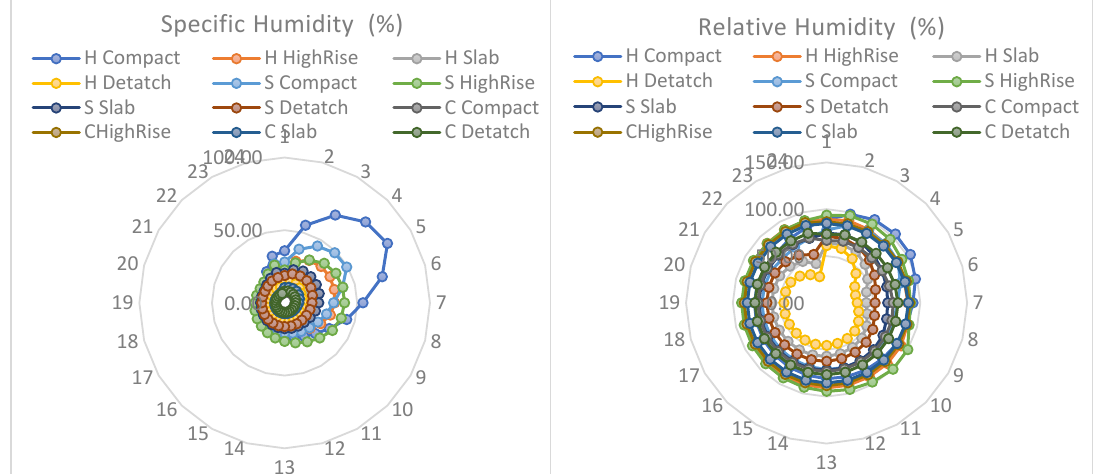
Fig. 11: Specific Humidity on the hottest, coldest and sultriest day of the year in the form of four morphotypes in the current situation